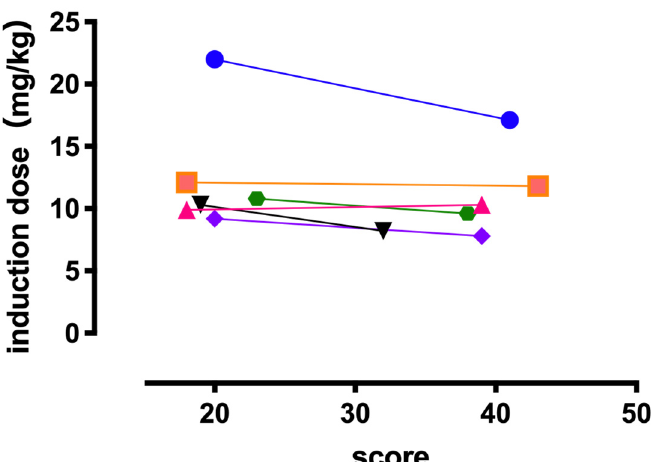
Figure 3. Each circle indicates the total behavioral evaluation score of each cat. It shows the correlation between the behavioral evaluation score plotted on the horizontal axis and the propofol dose requirement until the completion of endotracheal intubation plotted on the vertical axis.